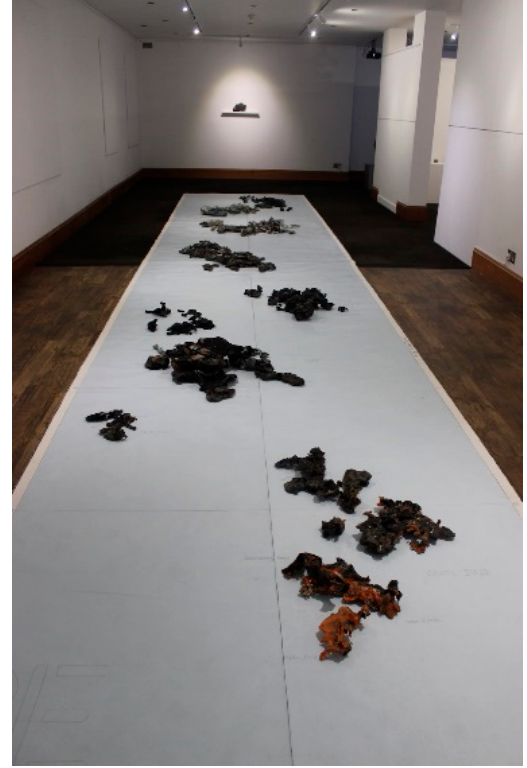
Figure 3. Archipelago . Floor installation overview and detail.